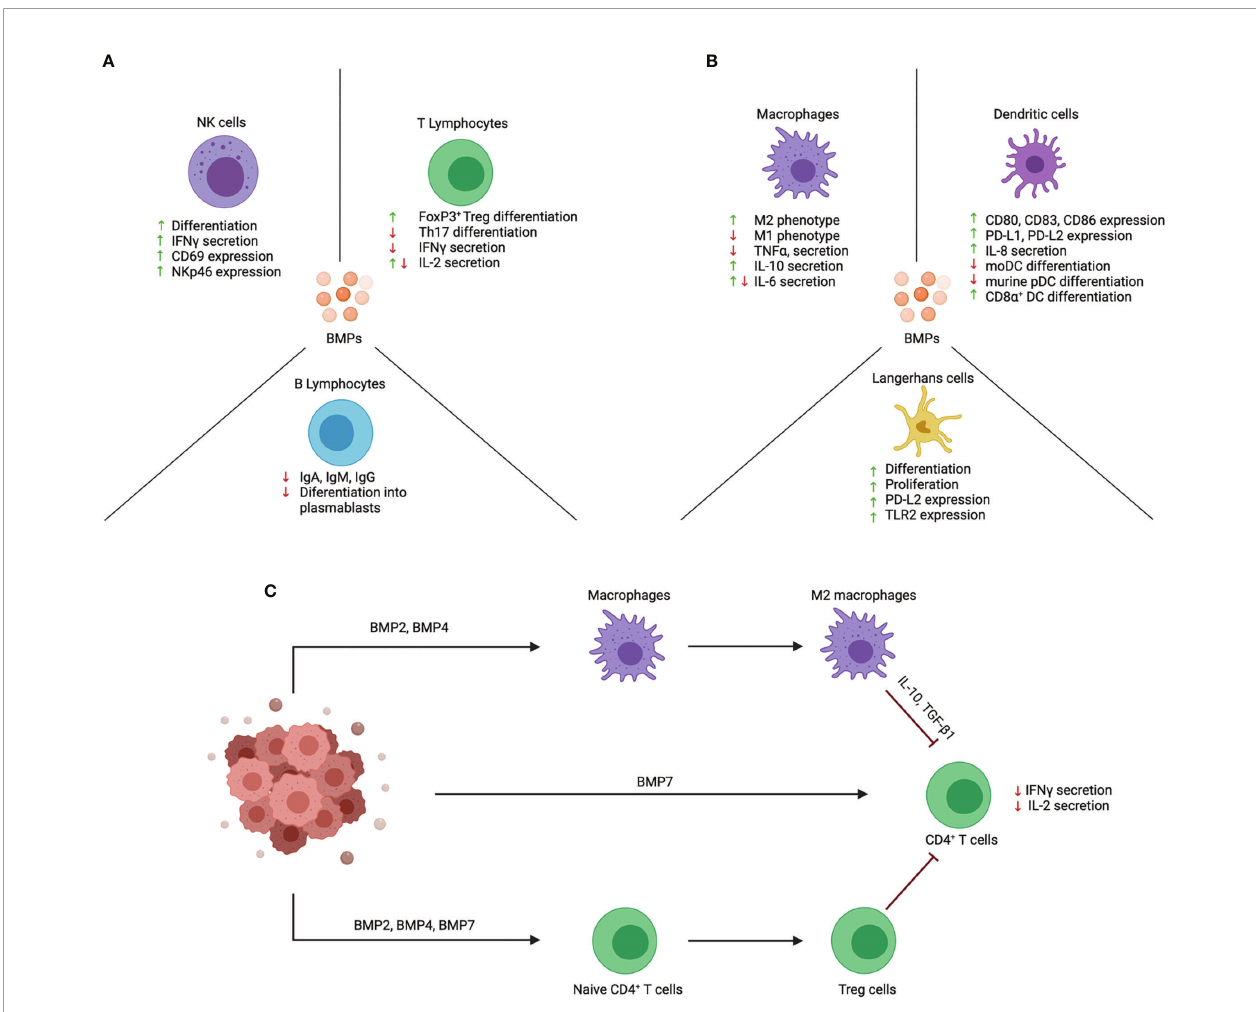
FIGURE 2 | Effects of BMPs on function and differentiation of immune cell subsets. BMPs act upon a wide variety of immune cells that are of lymphoid and myeloid origin. (A) BMPs have an activating effect on NK cells and promote their cytotoxic function. Instead, BMPs exert an anti-in fl ammatory effect on T lymphocytes. BMPs inhibit the differentiation of naïve CD4 + T cells into Th17 cells and promote Treg cell differentiation. B lymphocyte function is also repressed by inhibiting their differentiation into plasmablasts and Ig production. (B) The effect of BMPs on myeloid cells is mainly an anti-in fl ammatory effect. BMPs skew macrophages towards the anti-in fl ammatory M2 phenotype. In DCs, BMPs are involved in their activation and promote the expression of co-inhibitory markers (PD-L1 and PD-L2). In addition, BMPs promote LC proliferation and differentiation. (C) Proposed scheme on how BMPs contribute to immune evasion in cancer. BMPs are secreted in the tumor microenvironment and may promote immune evasion by inhibiting the function of tumor-in fi ltrating immune cells. BMPs can act directly on T cells and inhibit their function. BMPs also act by promoting immunosuppressive cells like Treg cells and M2 macrophages which in turn can inhibit effector T cell function. Created with